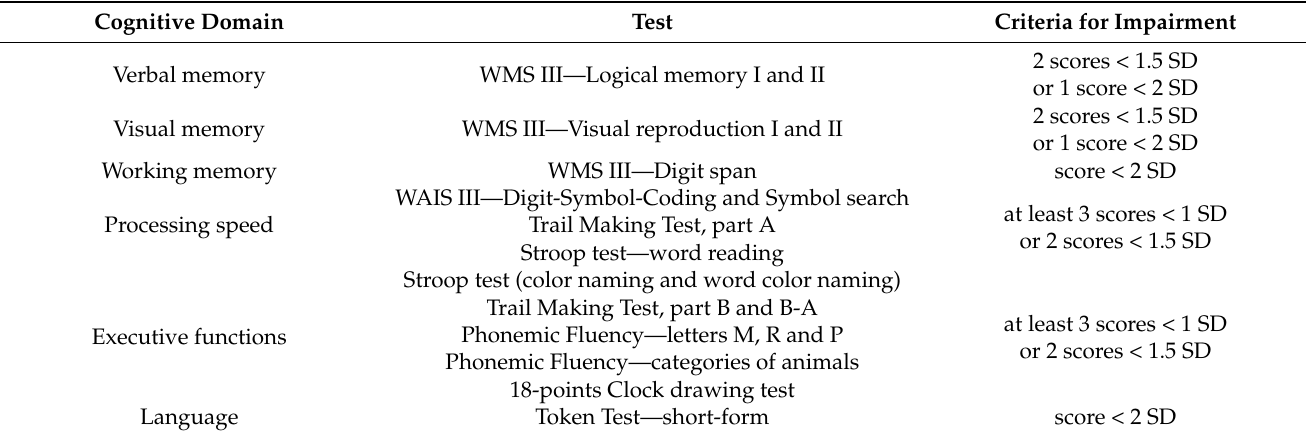
Table 1. Criteria used for the classification of cognitive impairment, considering the number of tests administered to assess each cognitive